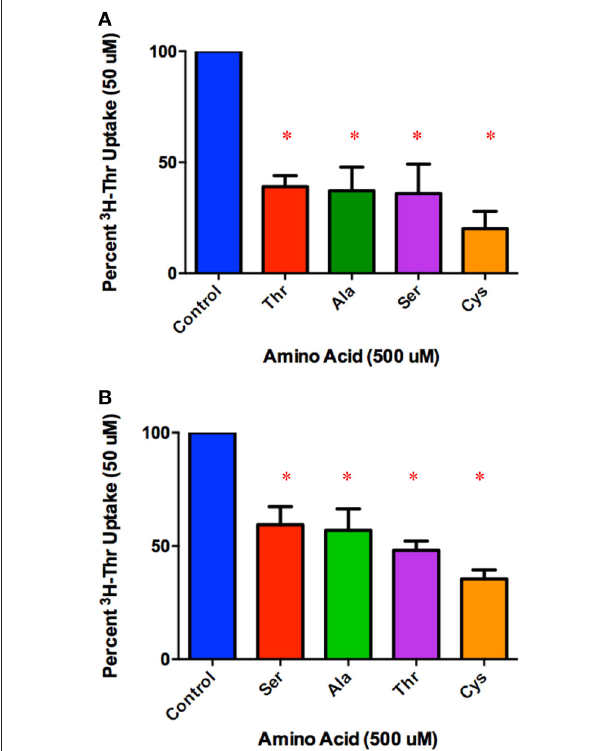
FIGURE 4 | Percent Na + -dependent uptake of 50 uM [ 3 H]-Thr remaining in the presence of the indicated amino acid (500 uM) (A) after subtraction of uptake in 140mM Choline Cl. A 1-sample t -test confirmed that all amino acids tested were significant inhibitors ( * p < 0.05 ). A one-way ANOVA indicated no statistically significant difference in [ 3 H]-Thr uptake in the presence of the different amino acids tested ( p > 0.05 ) ( n = 4 for each column; 2 determinations obtained in each of 2 independent experiments). (B) Percent uptake of [ 3 H]-Thr remaining in the presence of the indicated amino acid (500 uM) but without subtraction of Na + -independent transport. A 1-sample t -test confirmed that all amino acids were statistically significant inhibitors ( * p < 0.05 ). A one-way ANOVA indicated no statistically significant difference in [ 3 H]-Thr uptake in the presence of the different amino acids tested ( p > 0.05 ) ( n = 4 for each column; 3 determinations obtained in each of 2 independent experiments).